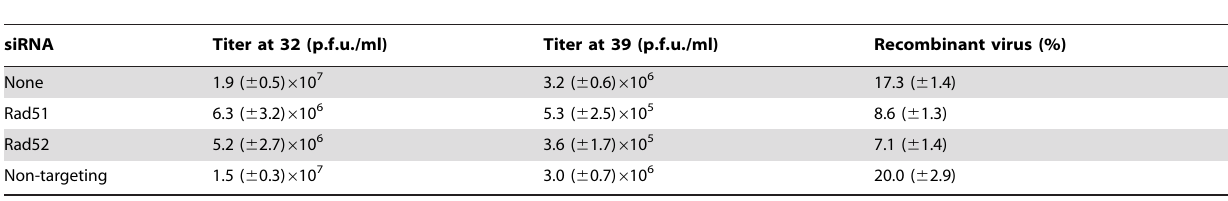
Table 1. Effects of siRNA on replication and recombination.